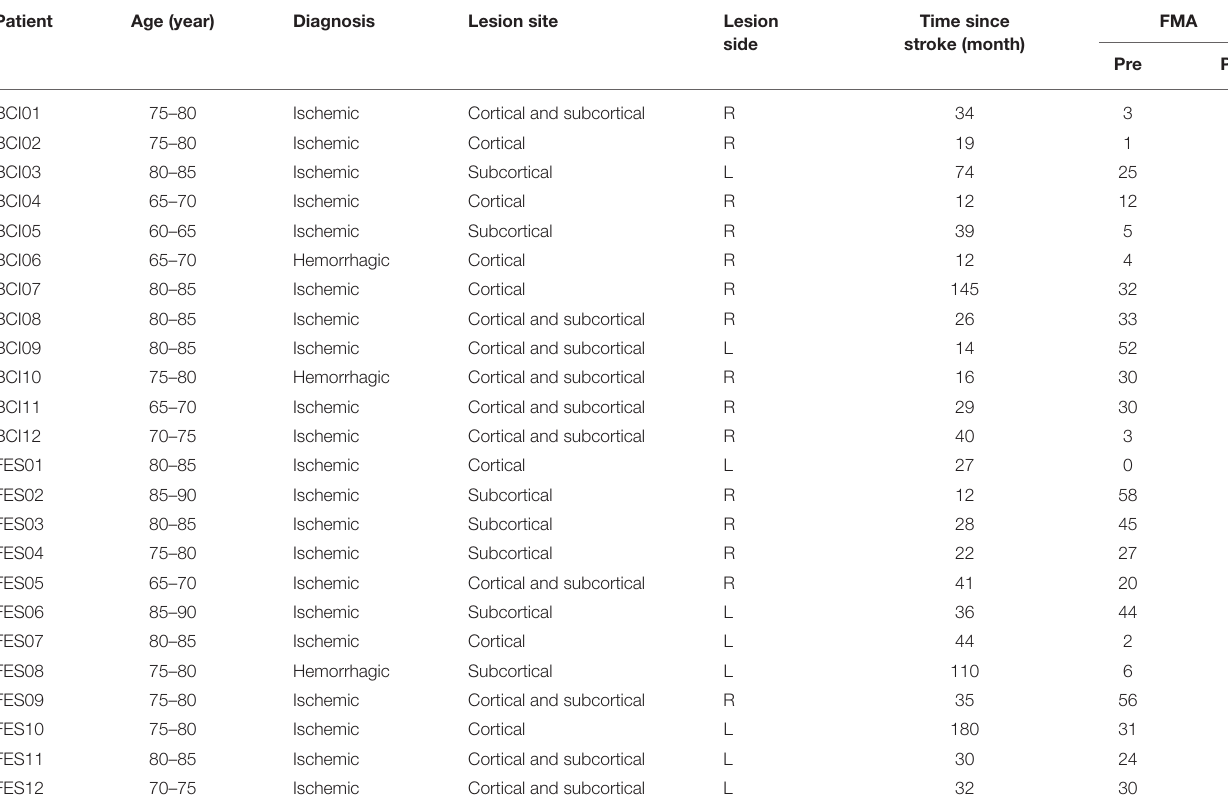
TABLE 1 | Baseline demographic data and clinical characteristics of